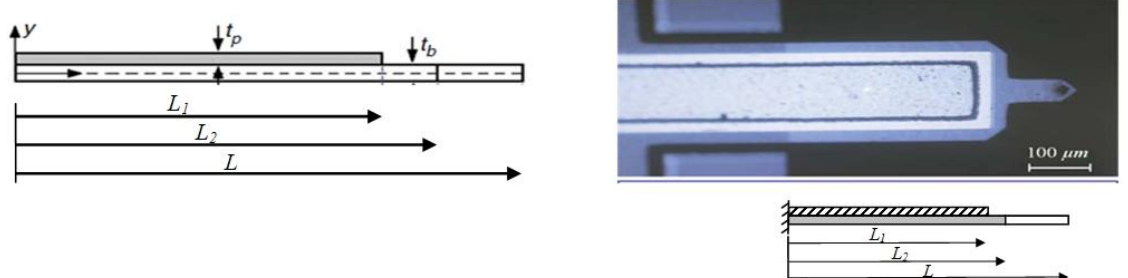
Figure 2. Micrograph/photograph of a Veeco Active Probe with a ZnO stack on top extended from 0 to l 1